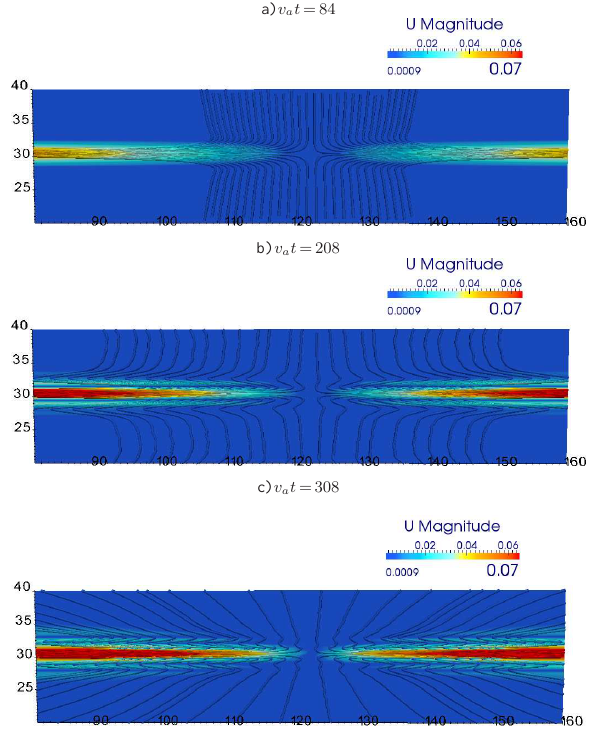
Fig. 5. Early evolution ( x − z plane). The flow lines are shown superimposed over a false colour representation of the flow speed. The SP layer first forms and the flow pattern around it changes its nature. Three times are shown. Blow up of the central region, the full box is 240x60.